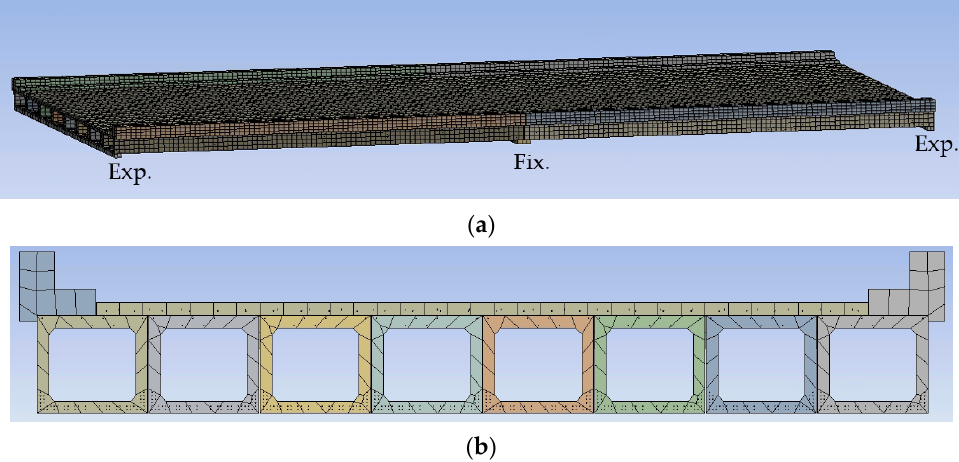
Figure 4. Snapshots from the FE model ( a ) overall look; ( b ) cross section.